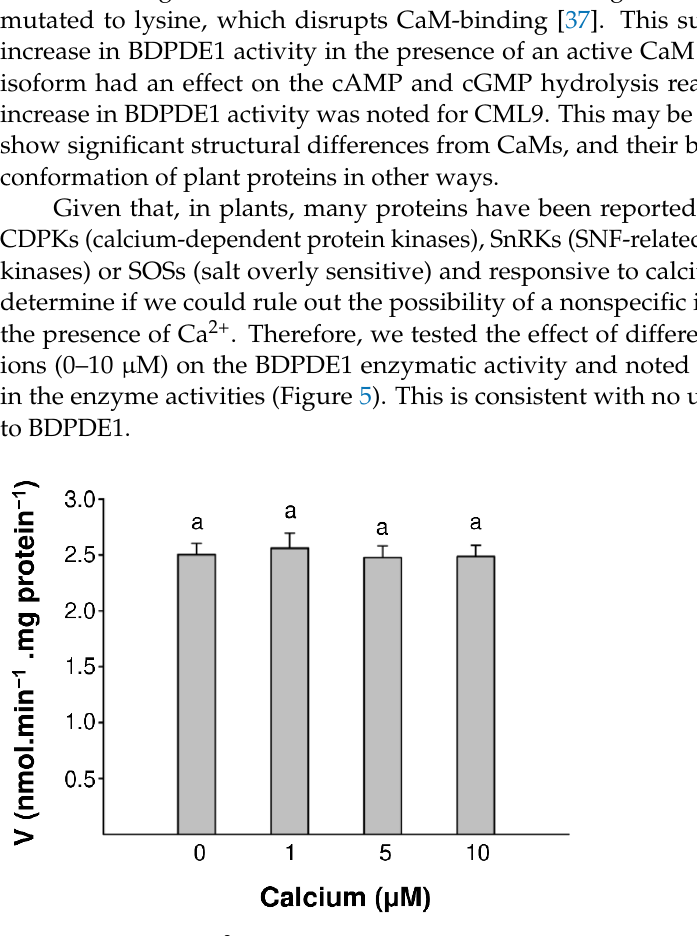
Figure 5. Impact of Ca 2+ ions on the GST-BDPDE1 activity. AMP generated in vitro after 25 min